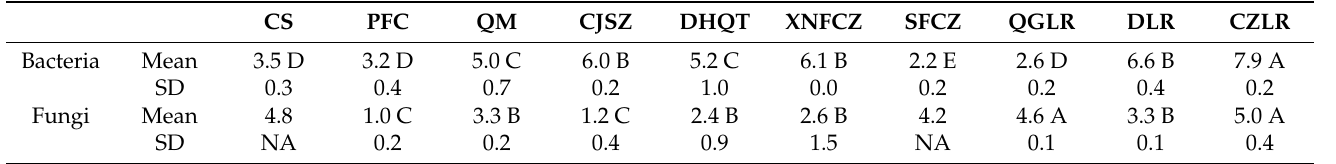
Table 1. Bacterial and fungal Shannon diversity indices in the seeds of eight anemochores and two